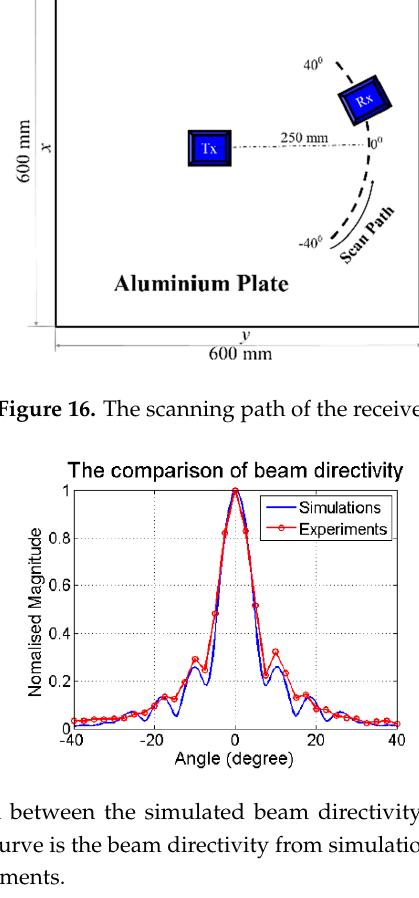
Figure 17. The comparison between the simulated beam directivity and the experimental beam directivity at z = 0. The red curve is the beam directivity from simulations, while the blue curve is the beam directivity from